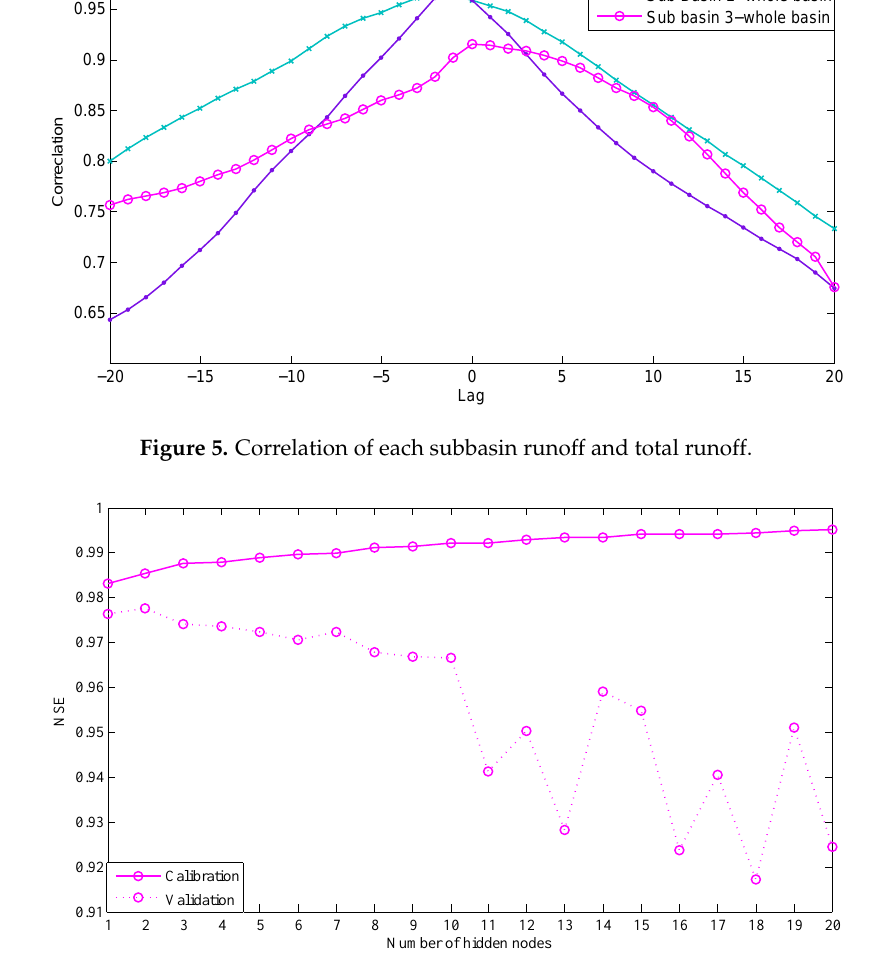
Figure 6. Performance of different quantities of ANN routing model (ARM) hidden